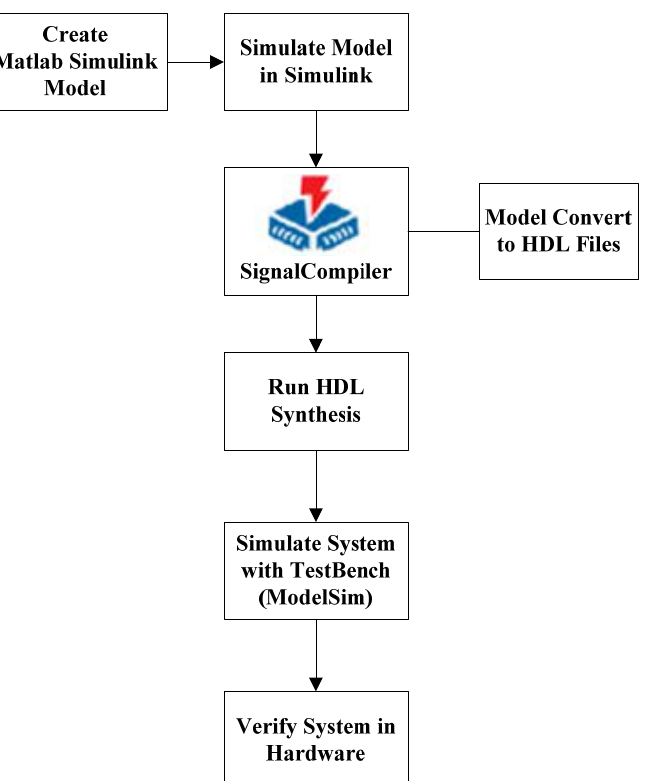
Figure 1. DSP Builder System-Level Design